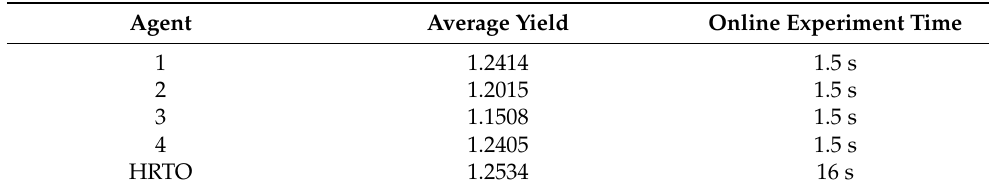
Table 3. Average yield and online experiment time for each agent.